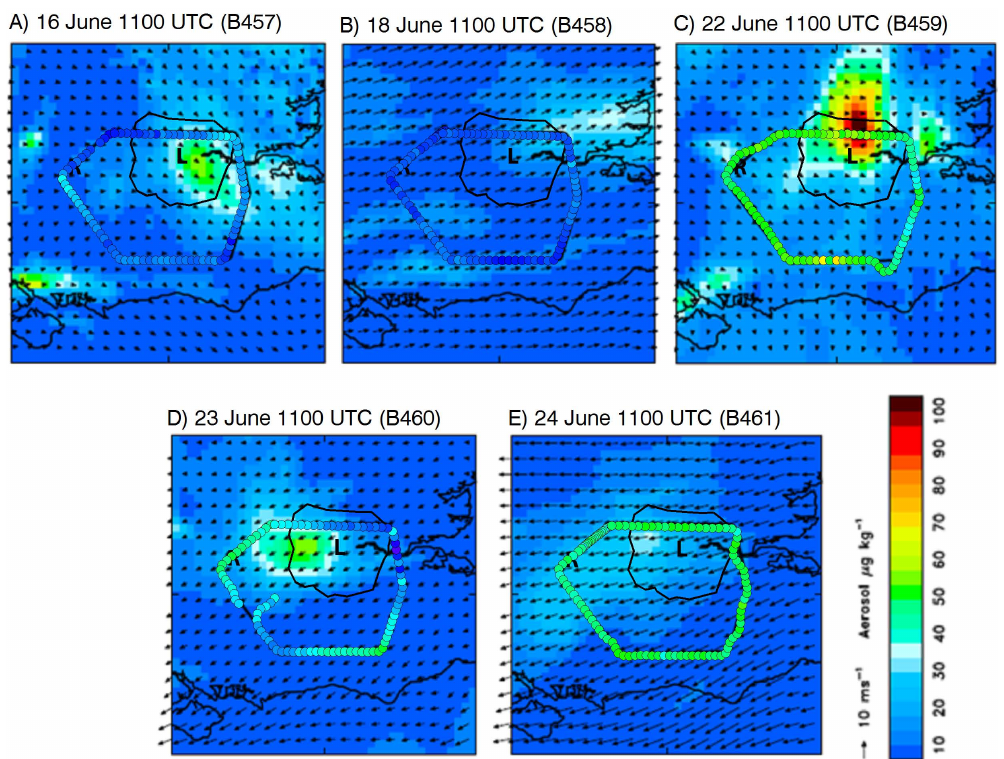
Fig. 4. Aerosol mass mixing ratios predicted at the 760 m altitude by the UK 4km visibility model for selected times during each flight day. Arrows indicate wind speed and direction at the predicted level. The “R” indicates the location of the city of Reading and “L” indicates the location of central London. Flight tracks for each day are shown by filled circles, shaded by total aerosol mass measured on the aircraft. Aircraft mass concentrations are shaded similar to model fields but multiplied by a factor of